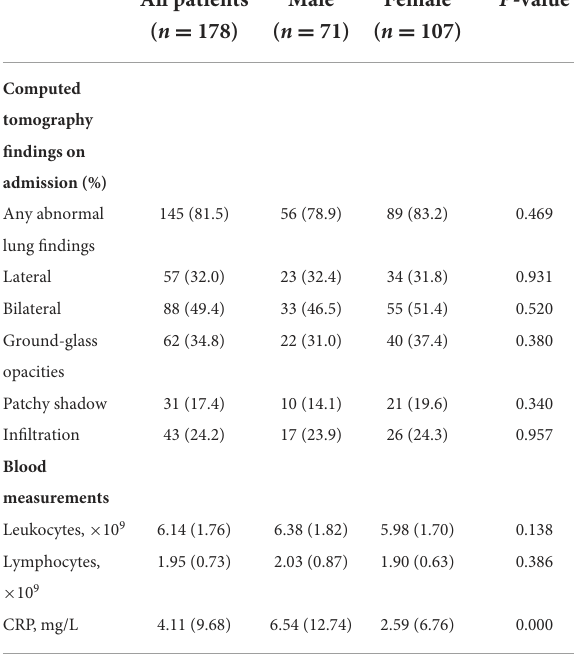
TABLE 5 Negative PCR conversion days and hospitalization days of infected subjects from overseas by gender. All